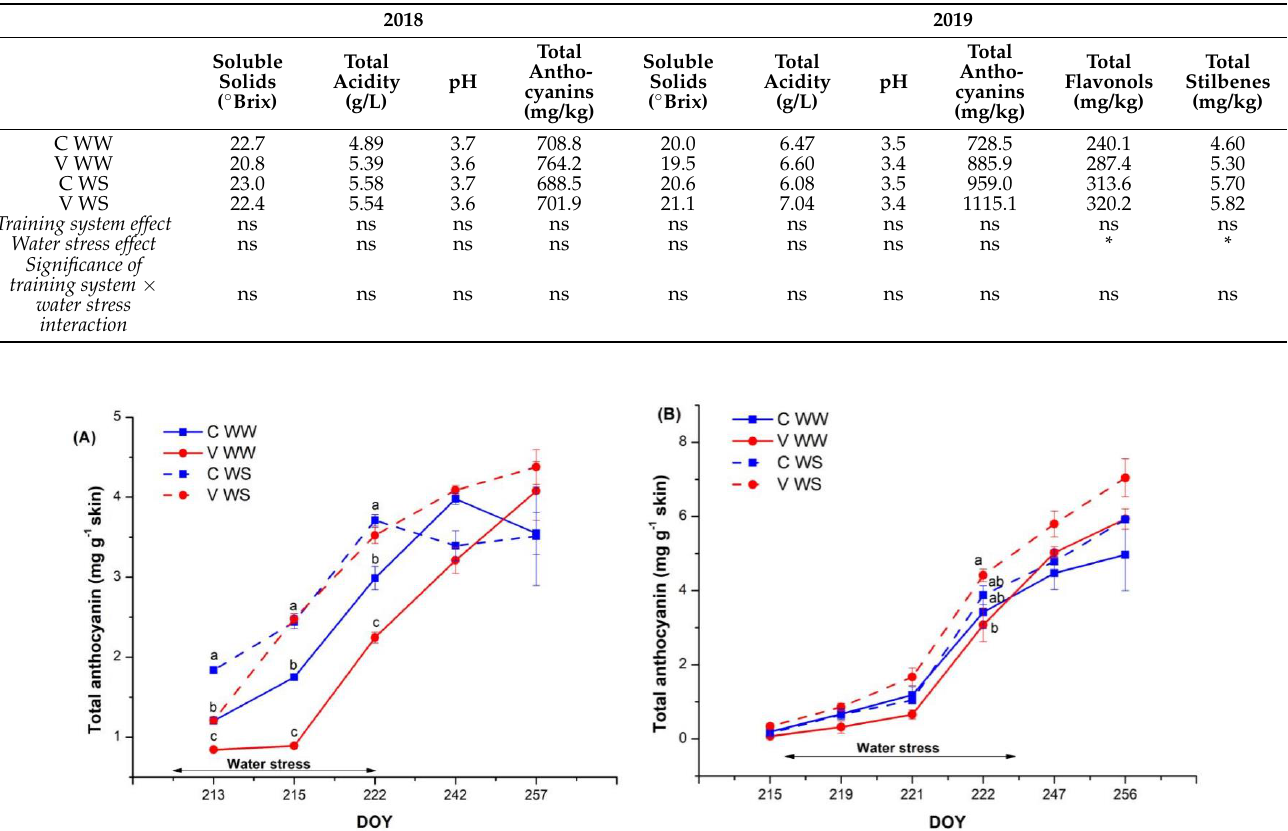
Figure 4. Evolution of total anthocyanin concentration (mg g -1 berry skin) in Sangiovese berries sampled in closed (C) and V (V) canopy-shaped vines under normal water supply (WW) or water stress at veraison (WS) in 2018 ( A ) and 2019 ( B ) seasons. Error bars indicate the mean SE (n = 4). Means followed by different letters differ significantly, as calculated by Tukey test ( p ≤ 0.05). The duration of the water stress period is indicated by black double arrows. Table 7. Influence of treatments on the standard parameters of the must and on the polyphenolic content of Sangiovese vines in the 2018 and 2019 seasons. Values represent means of 4 replicates: C WW = well-watered vertical shoot-positioned canopy, V WW = well-watered V-shaped open can- opy, C WS = vertical shoot positioned canopy with water restriction, V WS = V-shaped open canopy with water restriction. Significant differences are indicated: *, p < 0.05; ns, not significant. Mean val- ues were separated within each column with different letters using the Tukey test.